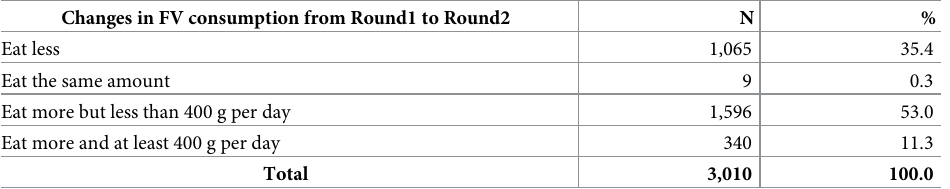
Table 2. Changes in frequency (N) and percentage (%) of FV consumption between Round1 (2018) and Round2 (2019). Changes in FV consumption from Round1 to Round2 N % Eat less Eat the same amount Eat more and at least 400 g per